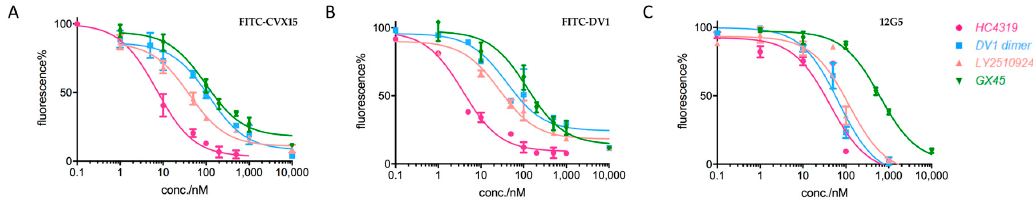
Figure 5. Competitive binding affinities of CXCR4 ligands Type 3 including HC4319, DV1 dimer, LY2510924, and GX45 respectively in ( A ) FITC-CVX15, ( B ) FITC-DV1, and ( C ) 12G5-based binding assays. Mean ± standard deviation; n = 3 independent experiments.